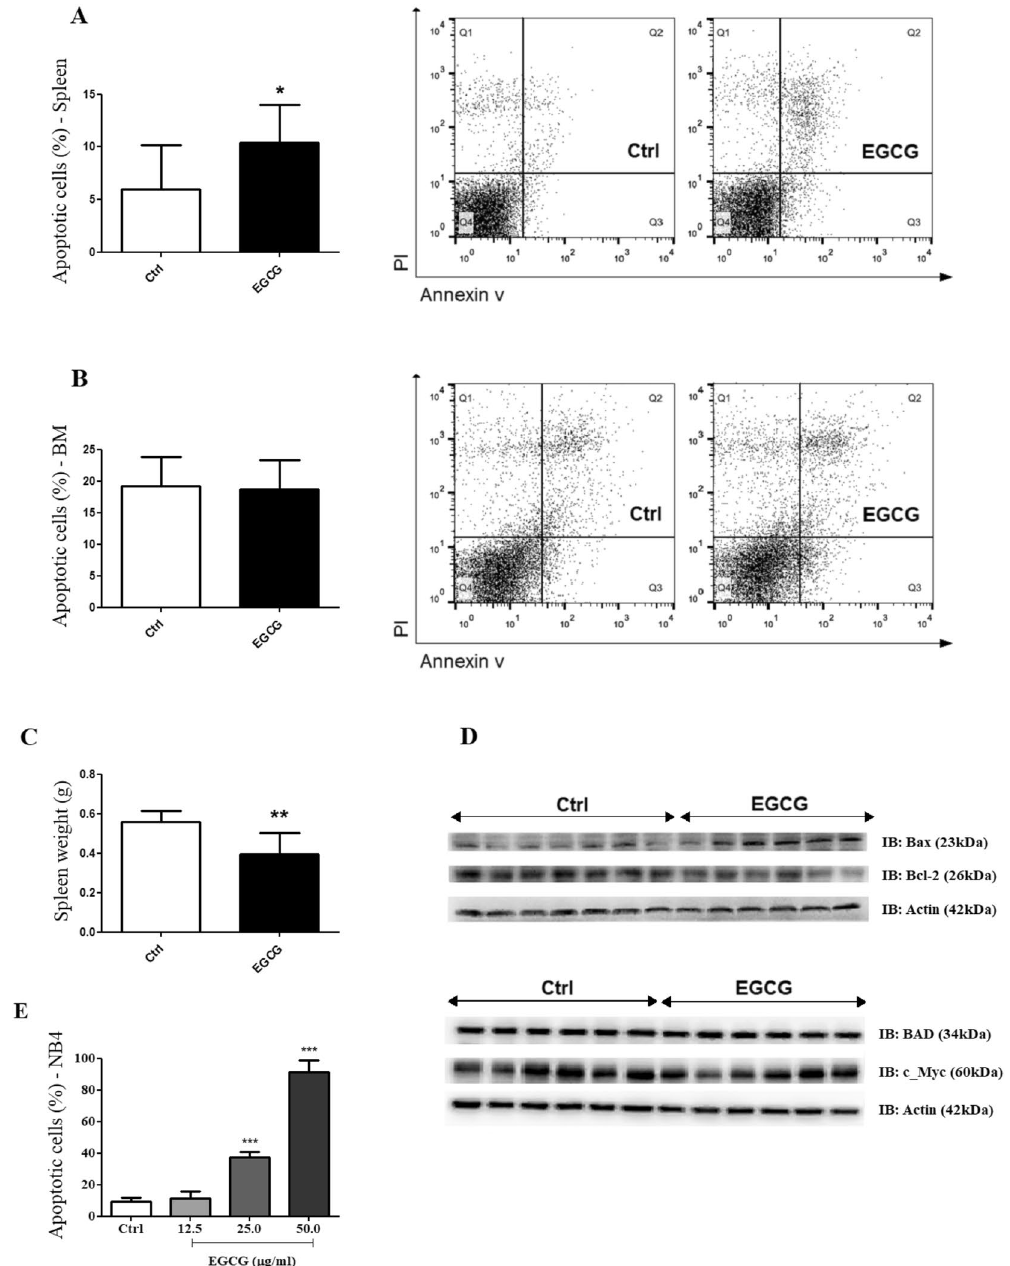
Figure 5. EGCG induces apoptosis of spleen cells by regulating BAX, BAD, BCL-2 and c-MYC expression. At the end of treatment (16th day) with EGCG (25 mg/kg/day i.p.) or vehicle (Ctrl), bone marrow (BM) and spleen cells of PLM/RARα mice were analysed by flow cytometry using Annexin-V/Propidium iodide and western blot. EGCG induced an increase of apoptosis in spleen cells ( A ), with no changes in bone marrow ( B ); representative dot plots of apoptosis analysis on the right. EGCG reduced spleen weights of PML/RARα mice ( C ) and increased expression of BAX and BAD whereas decreasing expression of BCL-2 and c-MYC ( D ). EGCG induced an increase in apoptosis in NB4 cells in a dose-dependent manner ( E ); three independents experiments. Gels were run under the same experimental conditions and the images of western blots displayed in cropped format. Full-length blots/gels are presented in Supplementary Figs. S4 and S5. Statistical significance (Student t test) is indicated as follows: * P < 0.05; ** P < 0.01; *** P <